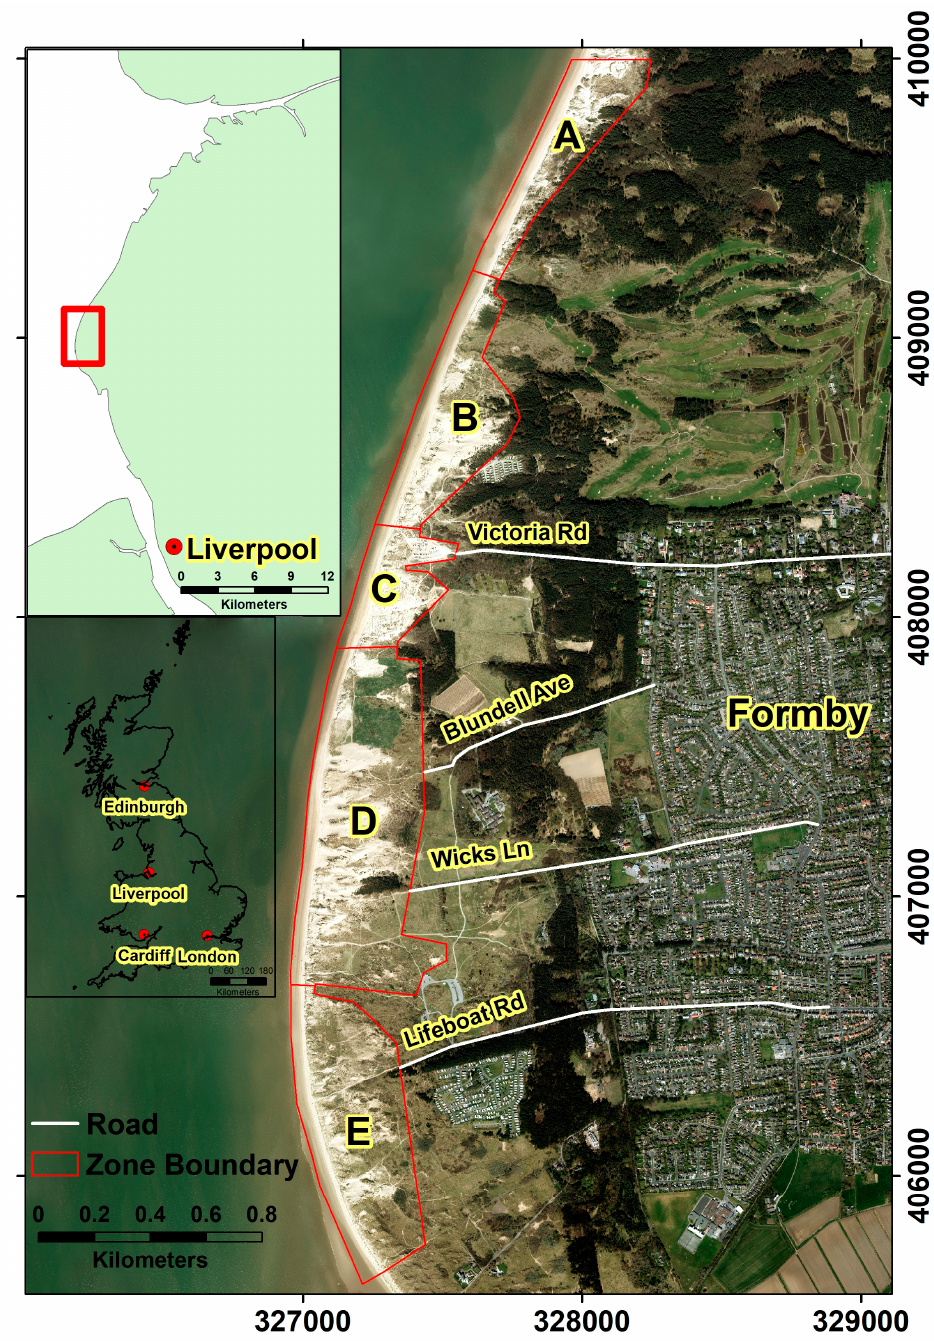
Figure 1. The Formby coast study area, showing the five zone divisions A, B, C, D, and E. (Background image and GB boundary layer © EDINA Digimap Ordnance Survey Service).